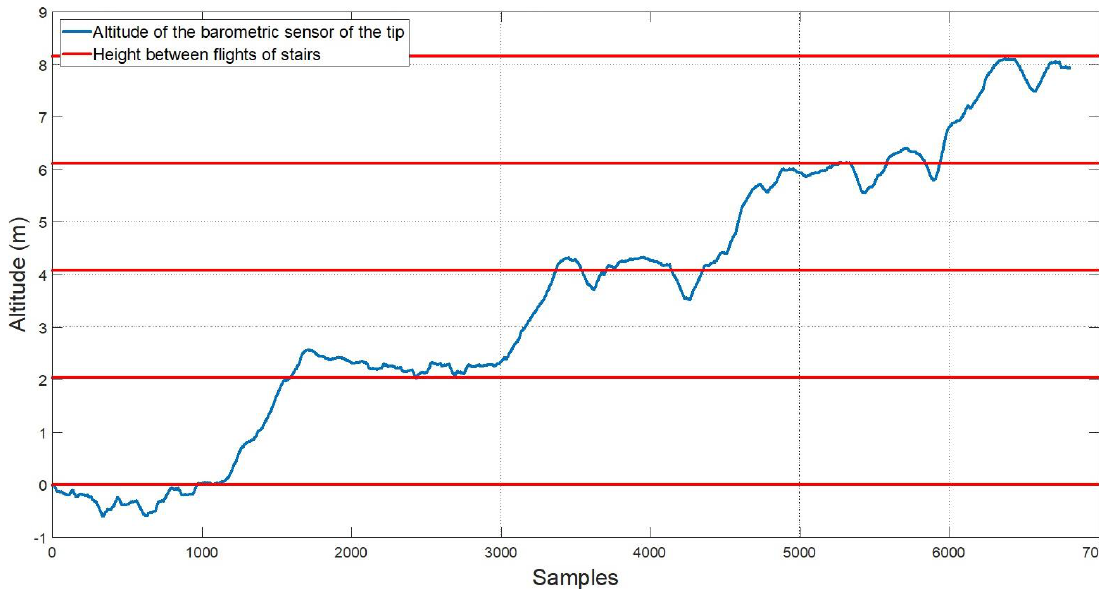
Figure 8. Comparison and validation of the altitude provided by the barometric sensor and the real